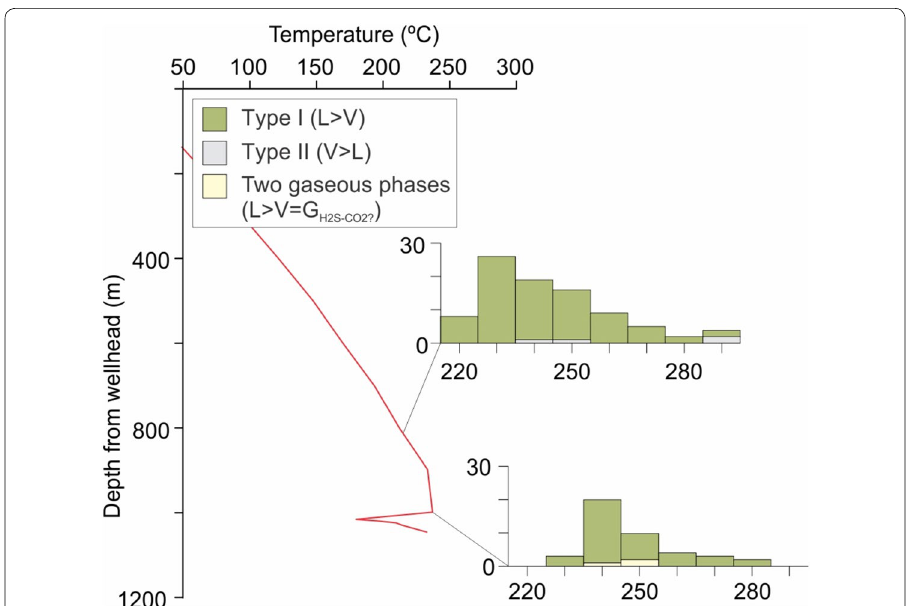
Fig. 6 Fluid inclusion of two levels (JICA 1992; Mas et al. 1993). L